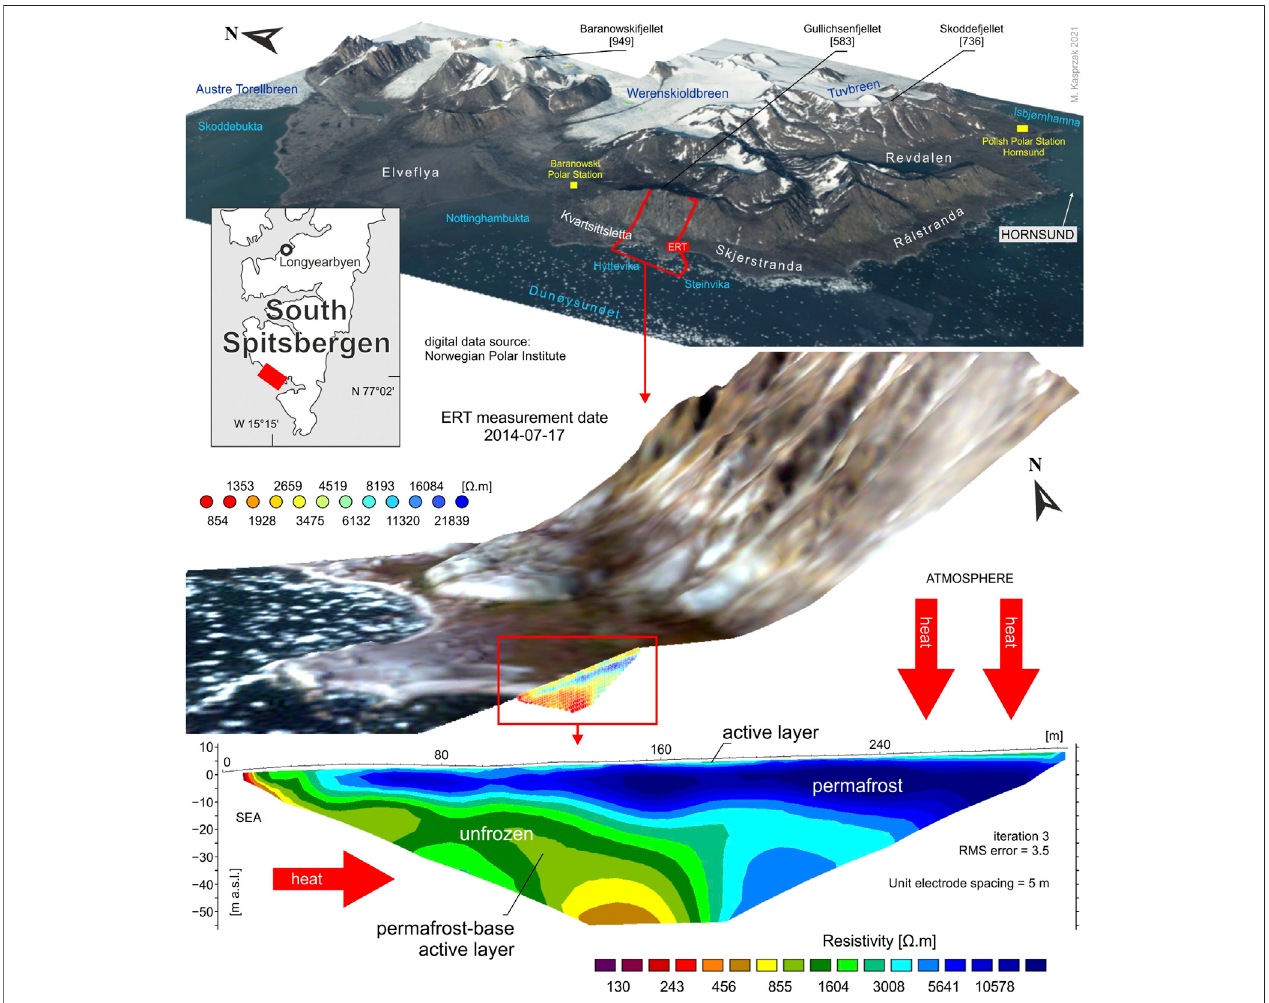
FIGURE5| Multidirectionalpermafrostdegradation;dominantchangeintheelectricalresistivityofthegroundiscausedbytheintrusionofseawater.Examplefrom the Gulf ofHytte, Svalbard, August 2014. The geoelectric properties in this case refer directly to the temperature ofthe ground. Frozen rocks lose their ability to conduct electricity. Deep blue colors shows “ permafrost wedge ” directing towards the sea-shore.